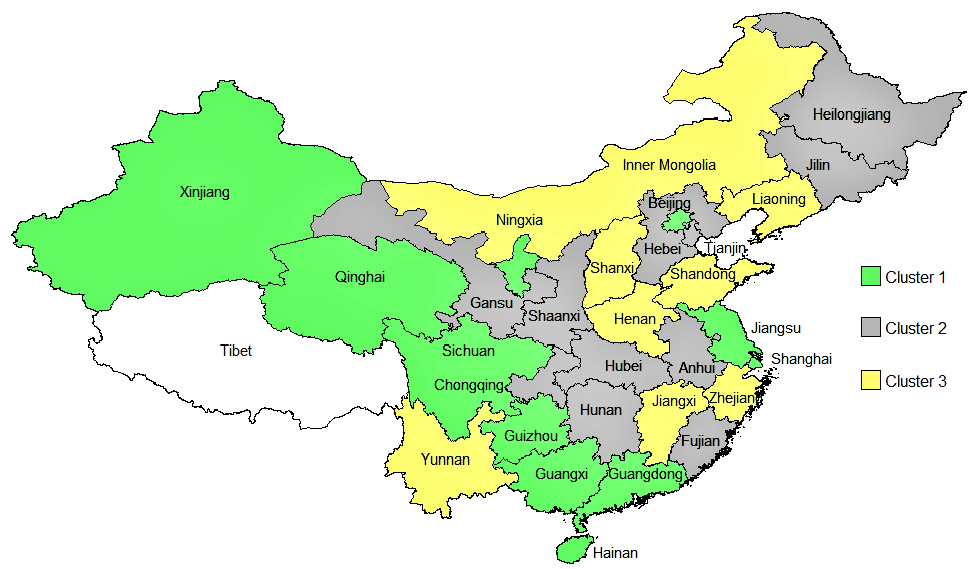
Figure 2. Provinces in Cluster 1, Cluster 2, and Cluster